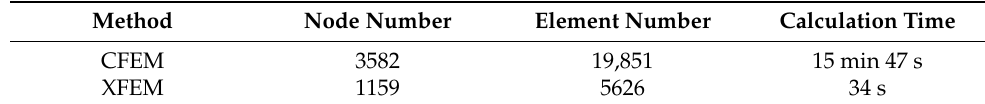
( b ) Figure 9. ( a ) 3D 10 bubbles mesh grid of CFEM; ( b ) 3D 10 bubbles mesh grid of XFEM. Table 6. The center position and radius of 10 bubbles. Number